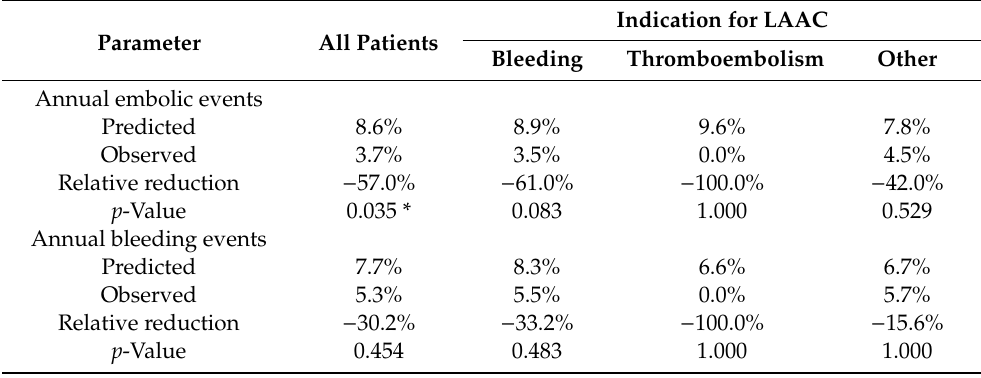
Table 3. Mean predicted annual stroke and bleeding events (as by CHA 2 DS 2 -VASc and HAS-BLED scores) compared to reported events in the Austrian LAAC